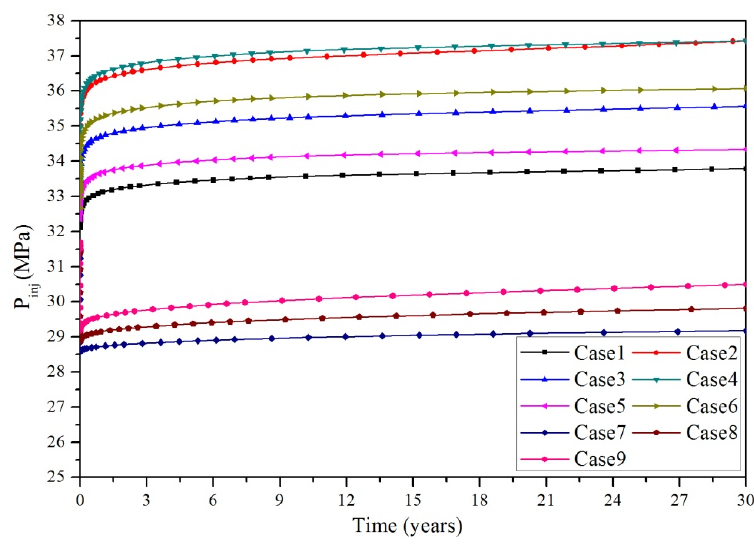
Figure 5. The injection pressure versus time in every case.